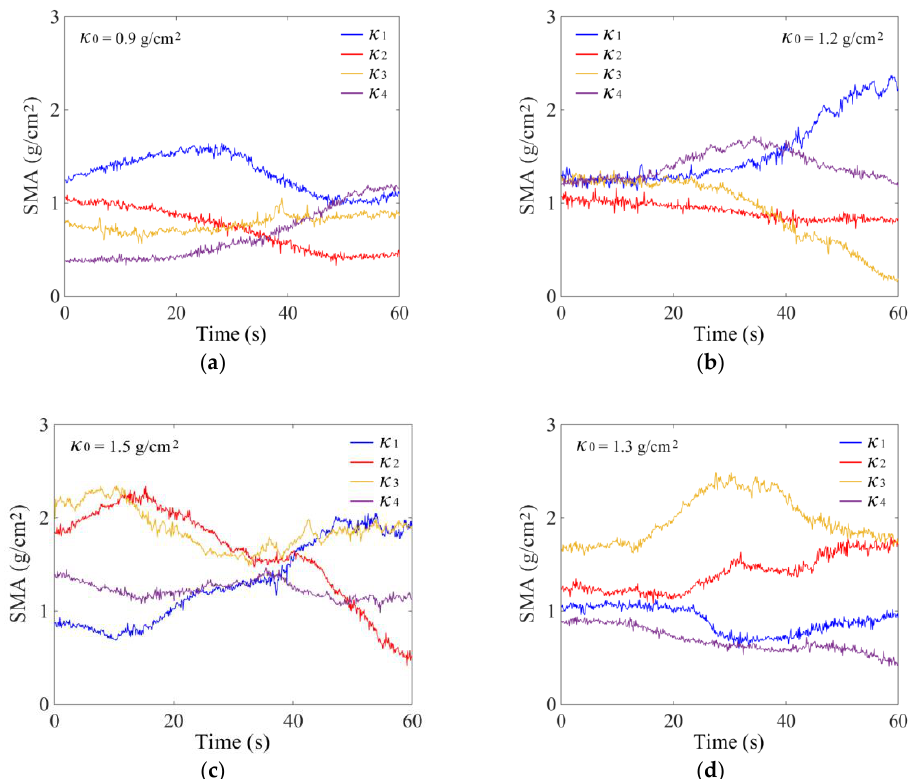
Figure 11. Experimental results of SMA in four monitoring areas: ( a ) κ 0 = 0.9 g/cm 2 , ( b ) κ 0 = 1.2 g/cm 2 , ( c ) κ 0 = 1.5 g/cm 2 , and ( d ) κ 0 = 1.3 g/cm 2 .